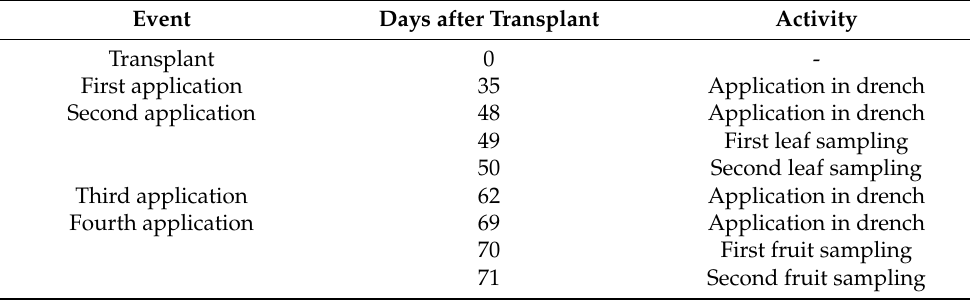
Table 1. Application of HYM and sampling of leaves and fruit of